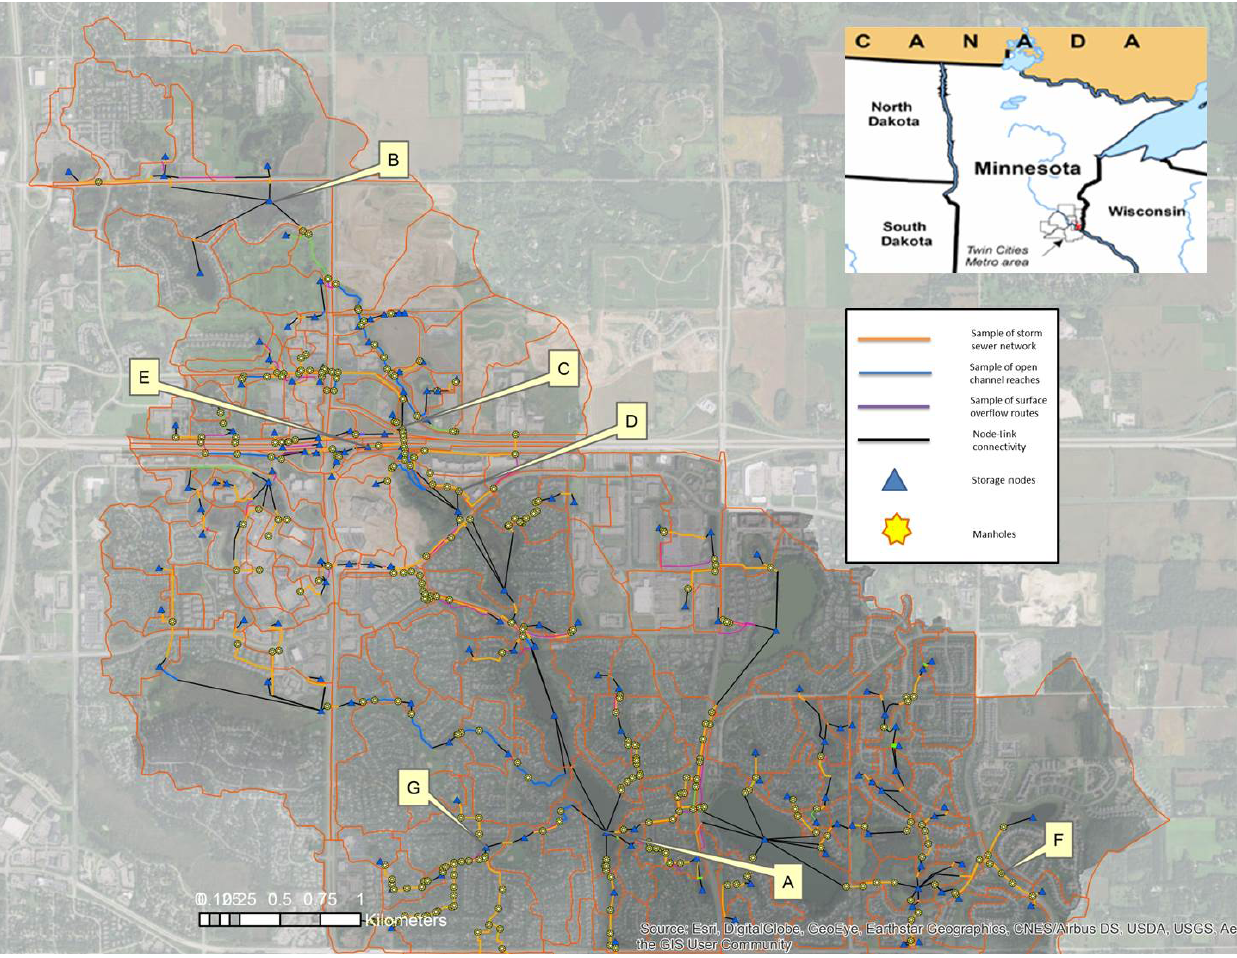
Figure 1. Location of the model and the sub-watersheds along with the reference points used in the discussion below. The details of the reference points and further explanation are presented in Table 1. The orange lines are an example of the sewer network geometry in the model. The blue lines represent reaches that are open channel. The magenta lines are the surface overflow routes that capture flow that tends to flood in areas and spread outside the sewer network. The black lines provide connectivity when the georeferenced locations of nodes are geographically different to the ends of some of the sewer